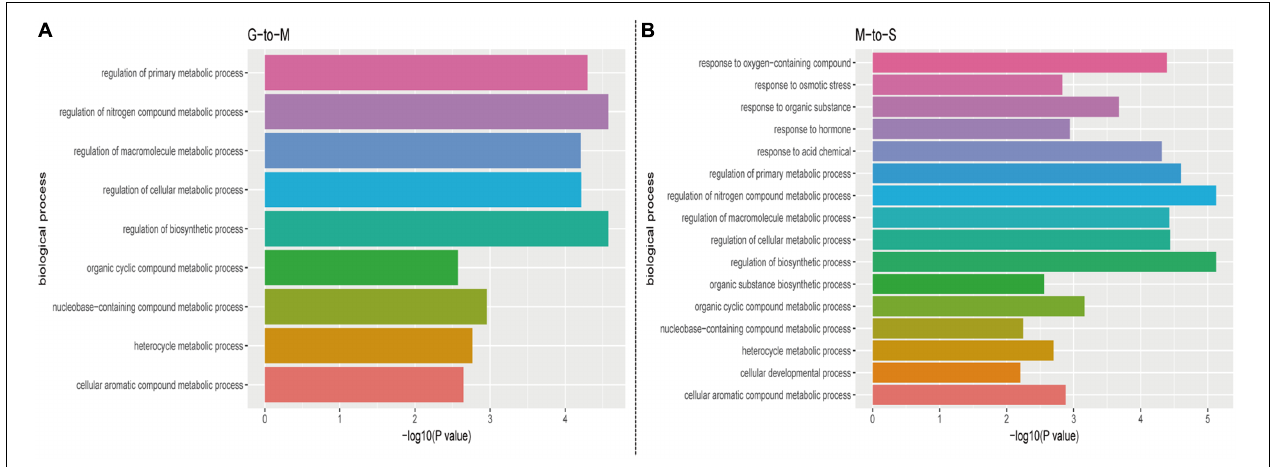
FIGURE 4 | The biological process profile of the target genes of the differentially expressed circRNAs during (A) G- to -M stage (B) M- to -S stage. ( P -value < 0.01).